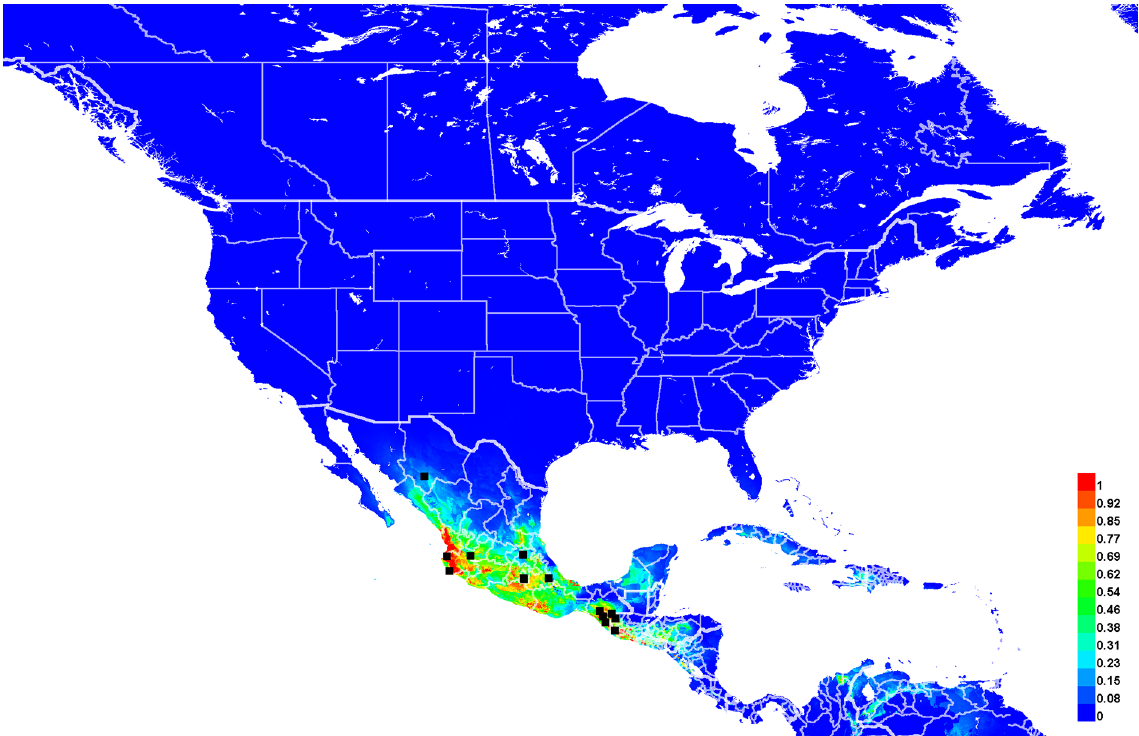
Fig. 83. Georeferenced collection records of Lasioglossum ( D. ) tessellatosum sp. nov. (black squares) and predicted distribution by maximum entropy ecological niche modeling in Maxent (colour shading). Warmer colours indicate higher cloglog probability of